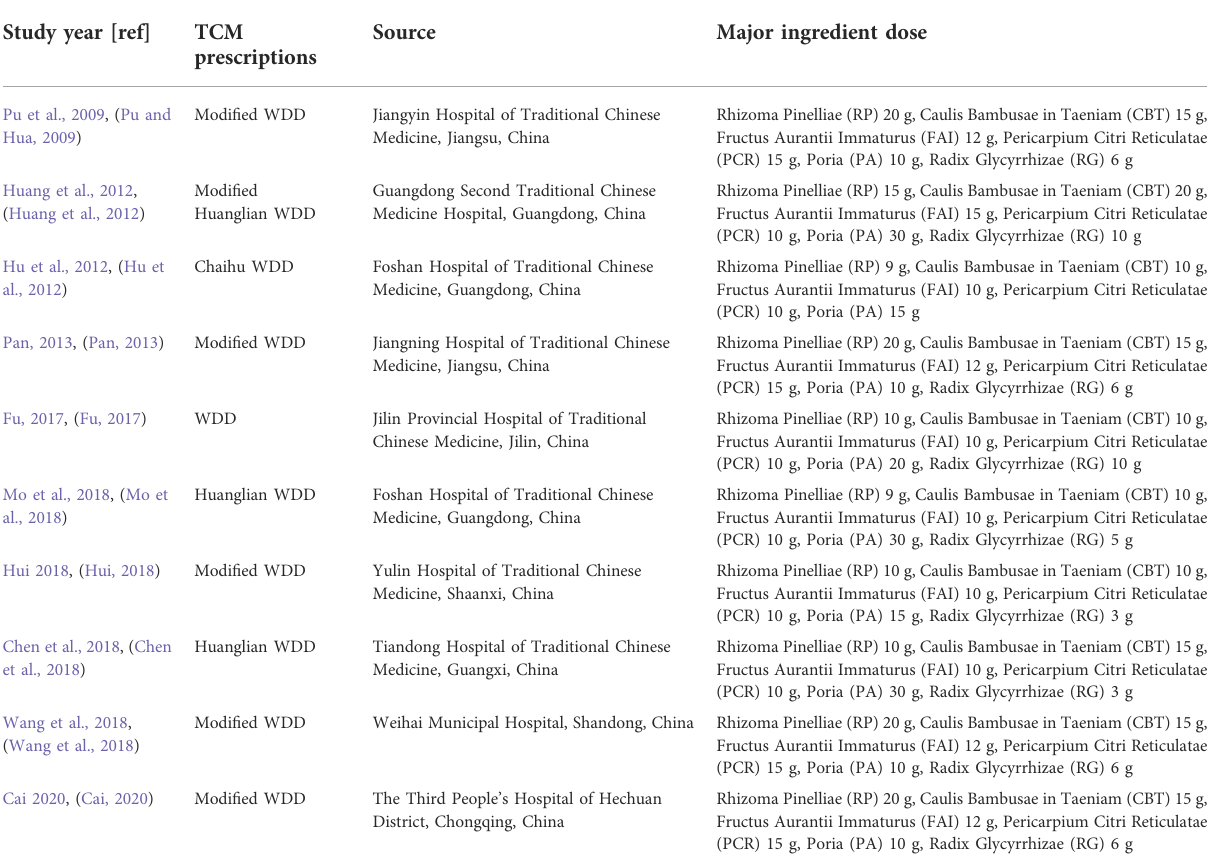
TABLE 3 Quality control of the TCM